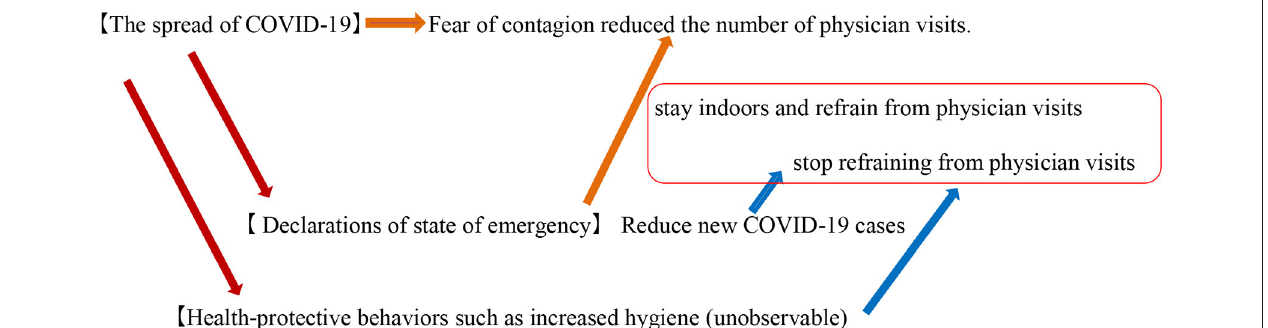
FIGURE 3 | Influence of the state of emergency